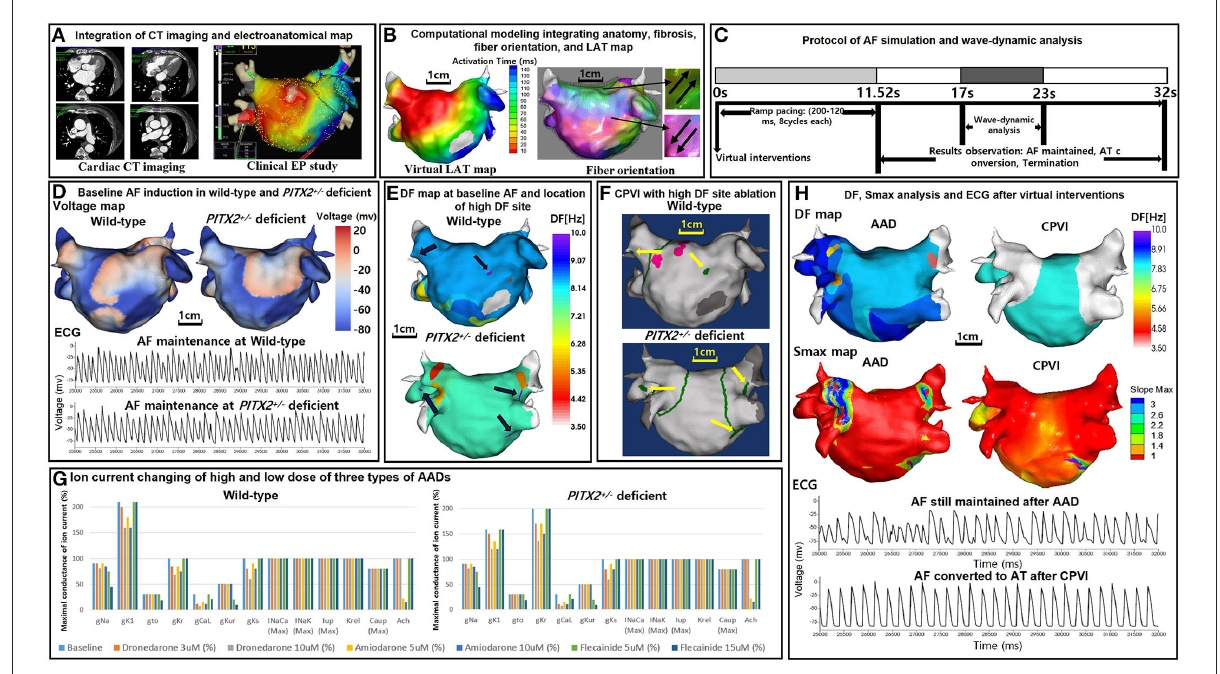
FIGURE1 Study protocol of the computational atrial modeling, AF simulation, and virtual interventions. (A) Integration of the CT imaging and electroanatomical map. (B) Computational modeling integrating the anatomy, fibrosis, fiber orientation, and LAT map. (C) Protocol of the AF simulation and wave-dynamic analysis. AF was induced in each case using AF pacing from 200 to 120ms with eight beats per cycle lasting a total of 11,520ms based on the wild-type PITX2 + / − deficient AF baseline ion current settings. AF maintenance was observed for 20,480ms after induction (overall 32s including pacing), and the wave dynamics of the DF and Smax were analyzed from 17,000 to 23,000ms. (D) Baseline AF induction under wild-type and PITX2 + / − deficient backgrounds. The voltage maps and ECGs indicate a successful AF induction during the wild-type and PITX2 + / − deficient baselines. (E) 3D DF map of the baseline AF under wild-type and PITX2 + / − deficient backgrounds. The black arrows indicate the locations of the high DF sites on the 3D DF map. (F) Virtual CPVI with a high DF site ablation. The green lines indicate the CPVI and yellow arrows indicate the ablated regions of the high DF sites. The pink sites indicate the pacing site. (G) Ion current changes with the high and low doses of the three types of AADs. Ion current changes with the high and low doses of the three types of AADs under the wild-type and PITX2 + / − deficient backgrounds. For PITX2 + / − deficiency, the I K1 decreased by 25% and the I Kr increased by 100% as compared to that with the wild-type status, while the other ion currents remain the same as the wild-type. (H) Smax and DF analysis after AADs and the CPVI. The ECGs indicate AF was maintained after AADs, and AF converted to AT after the CPVI. CT, computed tomography; EP, electrophysiology; LAT, local activation time; PITX2 , paired-like homeodomain transcription factor 2; CPVI, complete pulmonary vein isolation; DF, dominant frequency; Smax, the Maximal slope of the restitution curves; AF, atrial fibrillation; AT, atrial tachycardia; ECG, electrocardiogram; AAD, antiarrhythmic